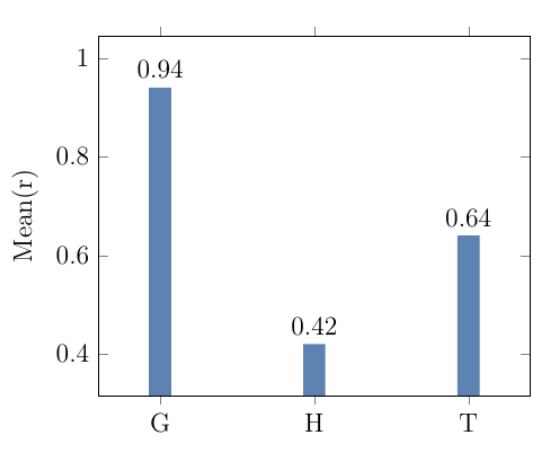
Figure 9. Pearson’s correlation coefficient, r x , y between the output power and the input variables: irradiance, G, air humidity, H and temperature, T.